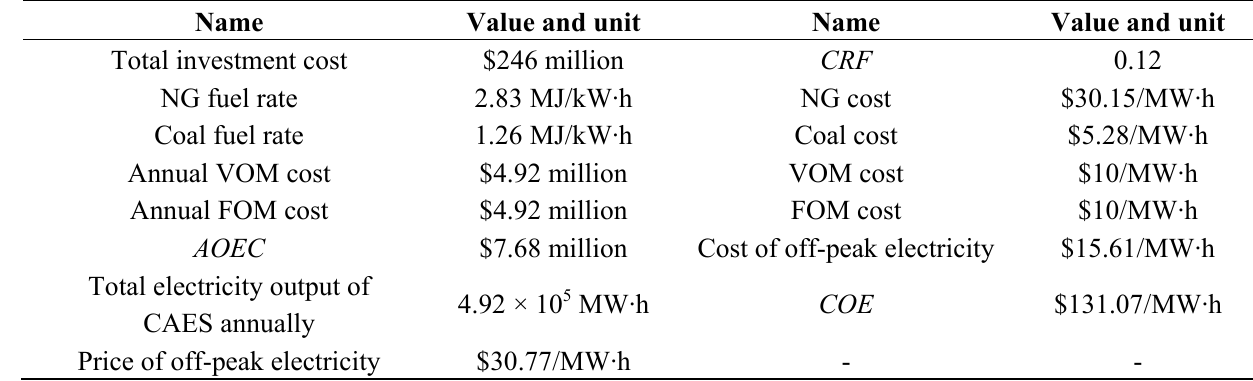
Table 8. Economic data of the hybrid-fuel 410 MW CAES plant. AOEC: annual off-peak electricity cost; CRF : capital recovery factor; and COE : cost of